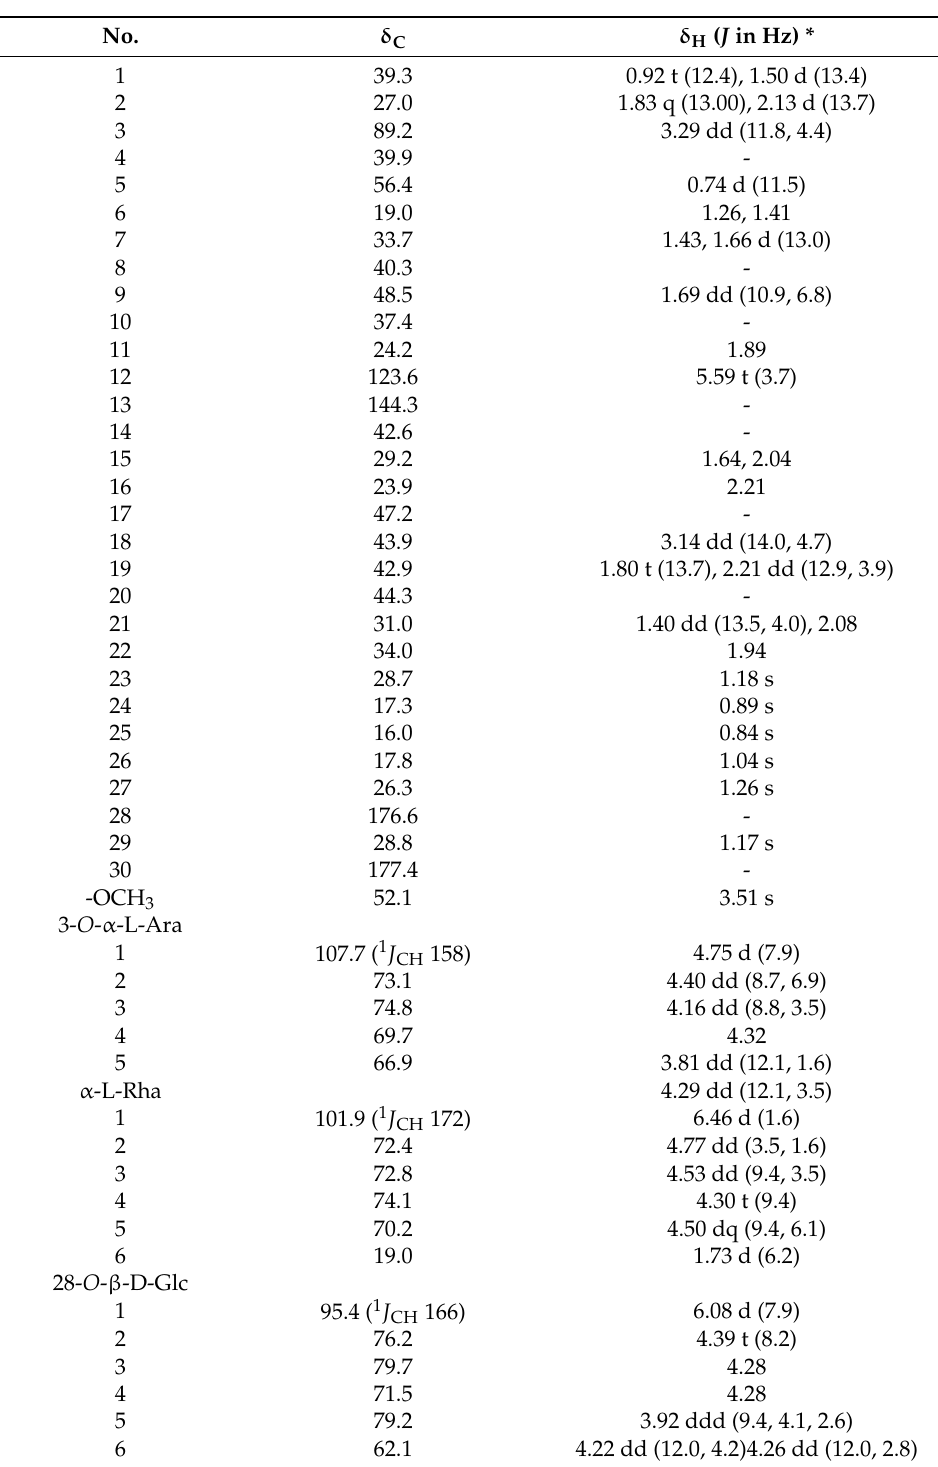
Table 1. 1 H (500 MHz) and 13 C (125 MHz) NMR spectral data ( δ ppm) for saponin 1 (pyridine- d 5 /D 2 O 250:10 with 0.2% trifluoroacetic